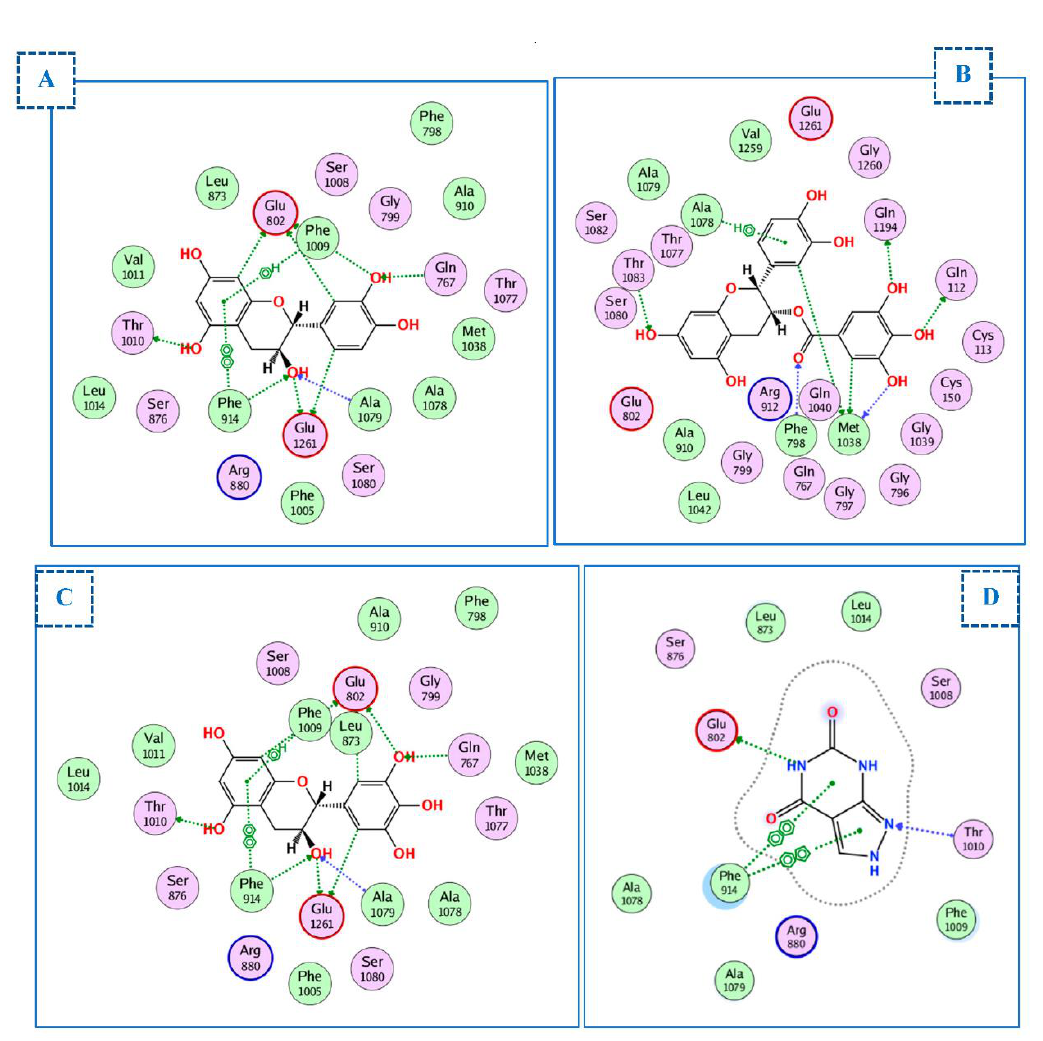
Figure 6. Two-dimensional diagram of ( A ) (+)-catechin, ( B ) (-)-epicatechin gallate, ( C ) (+)-gallocate- chin, and ( D ) oxypurinol into the binding site of xanthine oxidase (PDBID: